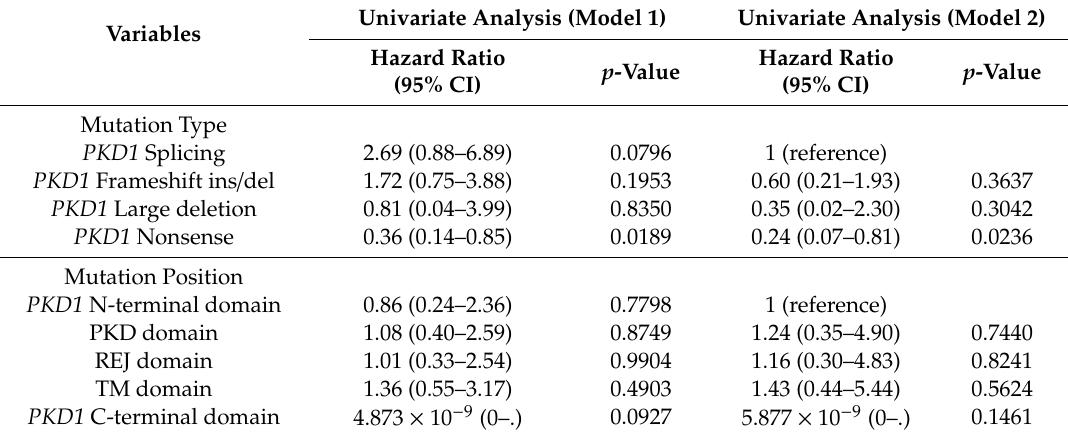
Table 4. Univariate analysis of risk factors associated with RRT ( PKD1 Truncating cohort, n =